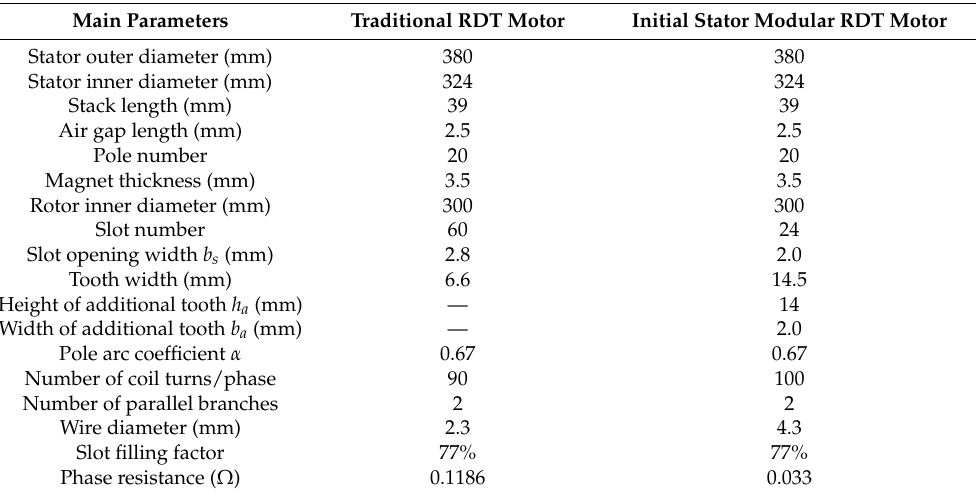
Figure 5. Structure parameters of the stator of the new RDT motor. Table 1. Main parameters of two RDT motors.